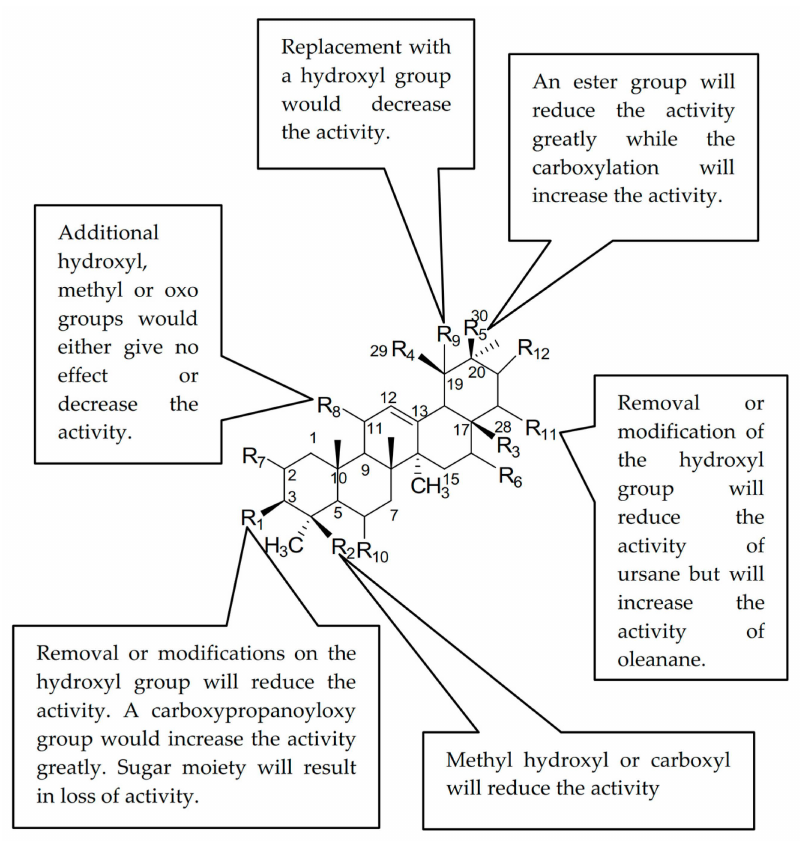
Figure 2. Structure activity relationship of pentacyclic triterpenes